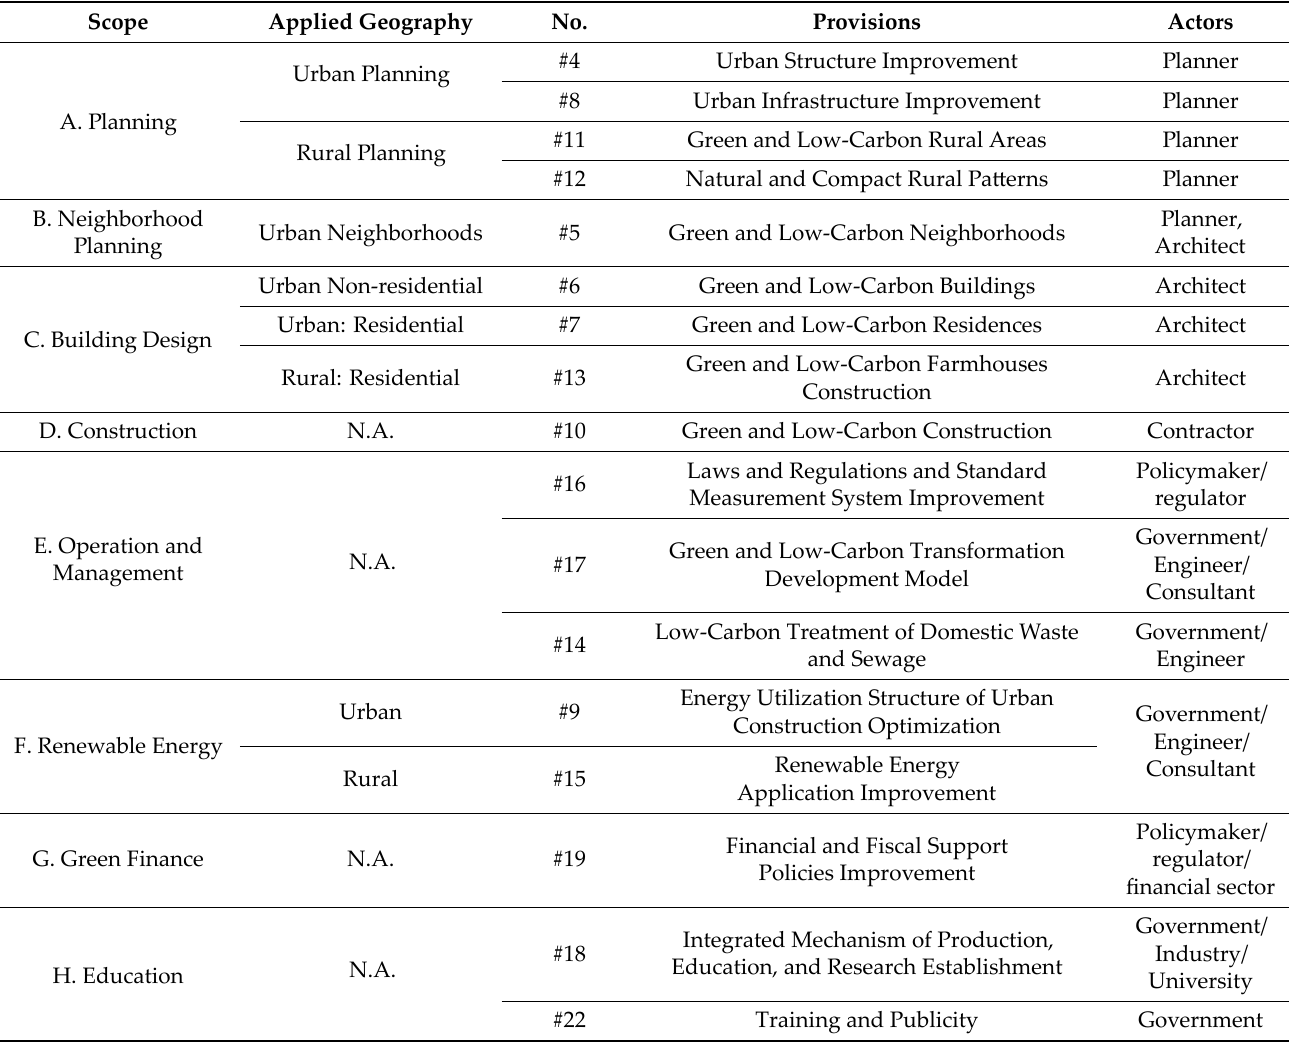
Table 2. Re‑classification of the policy instruments for carbon peaking in the building and construc‑ tion sector.